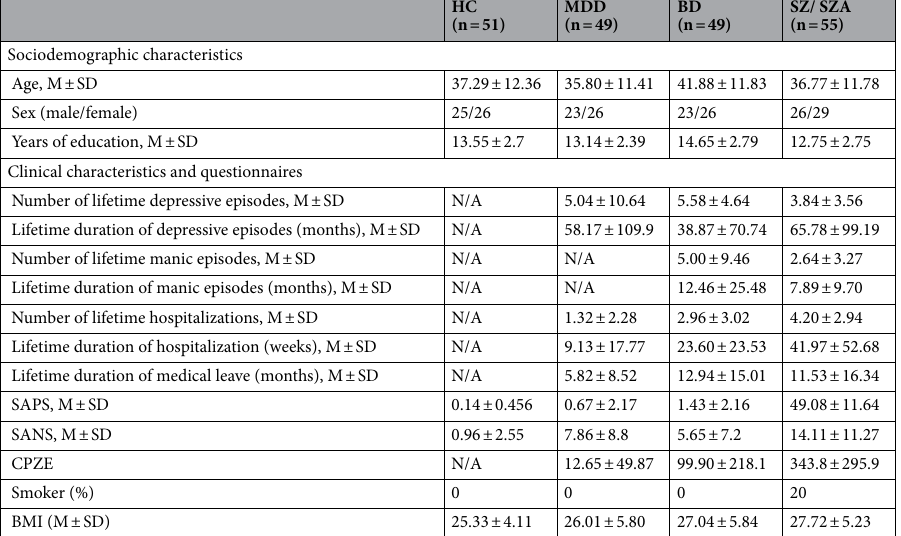
Table 1. Demographic and clinical characteristics of the study sample. BD bipolar disorder; BMI body mass index (Italic font), CPZE chlorpromazine equivalent; HC healthy controls; MDD major depressive disorder; SANS scale for the assessment of negative symptoms; SAPS scale for the assessment of positive symptoms; SD standard deviation; SZ schizophrenia; SZA schizoaffective disorder; n number; n/a not